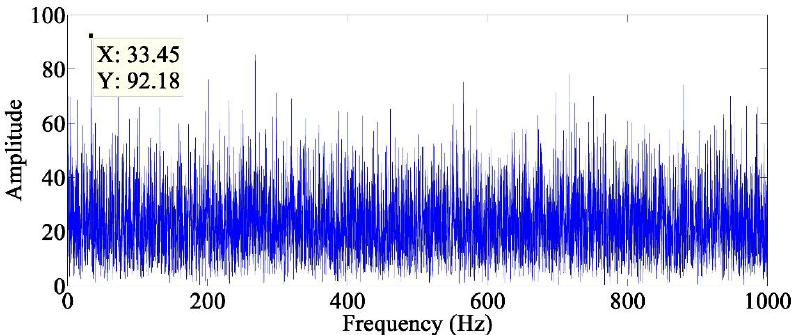
Figure 19. The amplitude spectra of the collected signal.